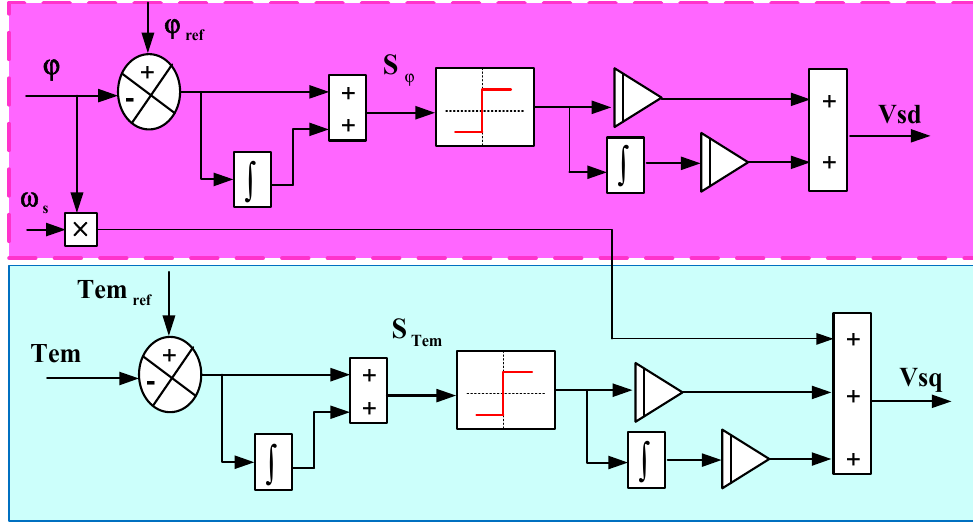
Figure 6. Commutation functions. 3.3. Simulation Results To substantiate the effectiveness of the proposed DTC-SM control strategy and eval- uate the designed control system’s dynamic response, we have modeled it in Matlab/Sim- ulink software. The applied reference speed profile of the given system is depicted in Fig- ure 7. Figure 7. Reference speed. 0 0.5 1 1.5-1000 100